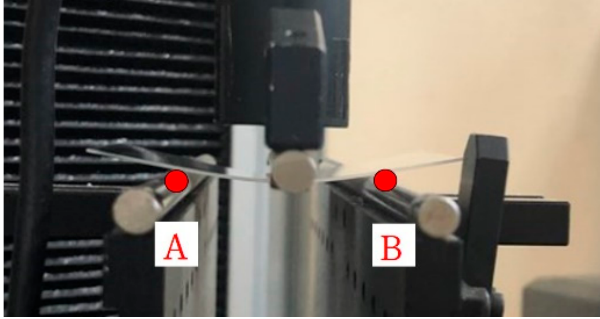
Figure 1. Three point bending test machine.